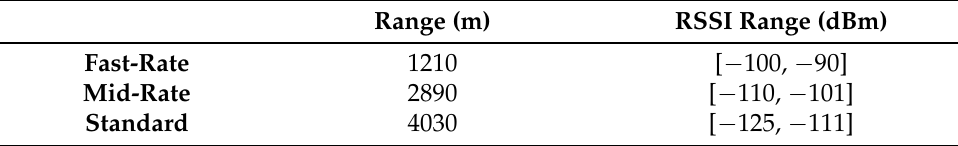
Table 3. Maximum communication and RSSI range for each LoRa channel.